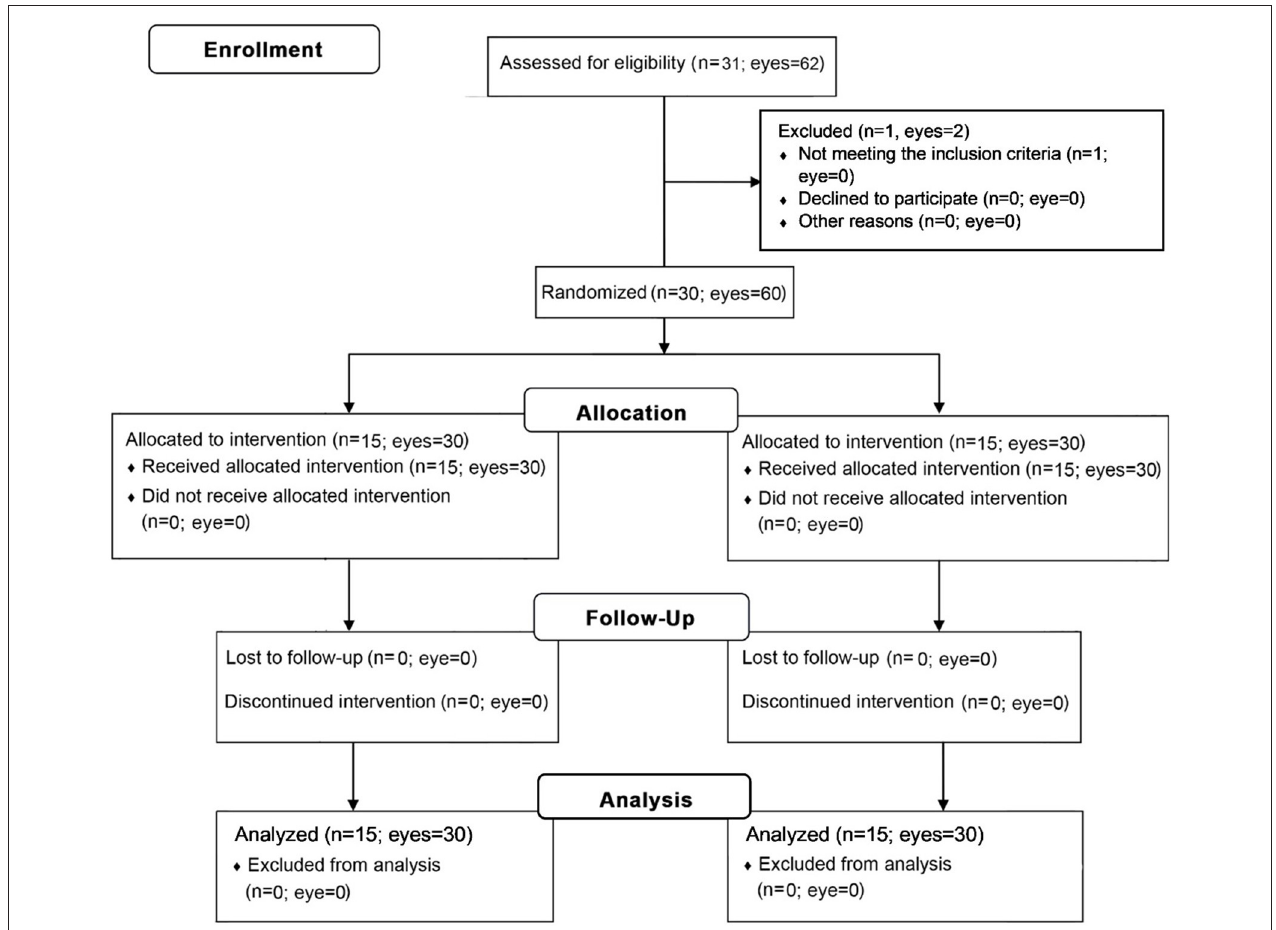
FIGURE 1 | Consolidated standards of reporting trials flow